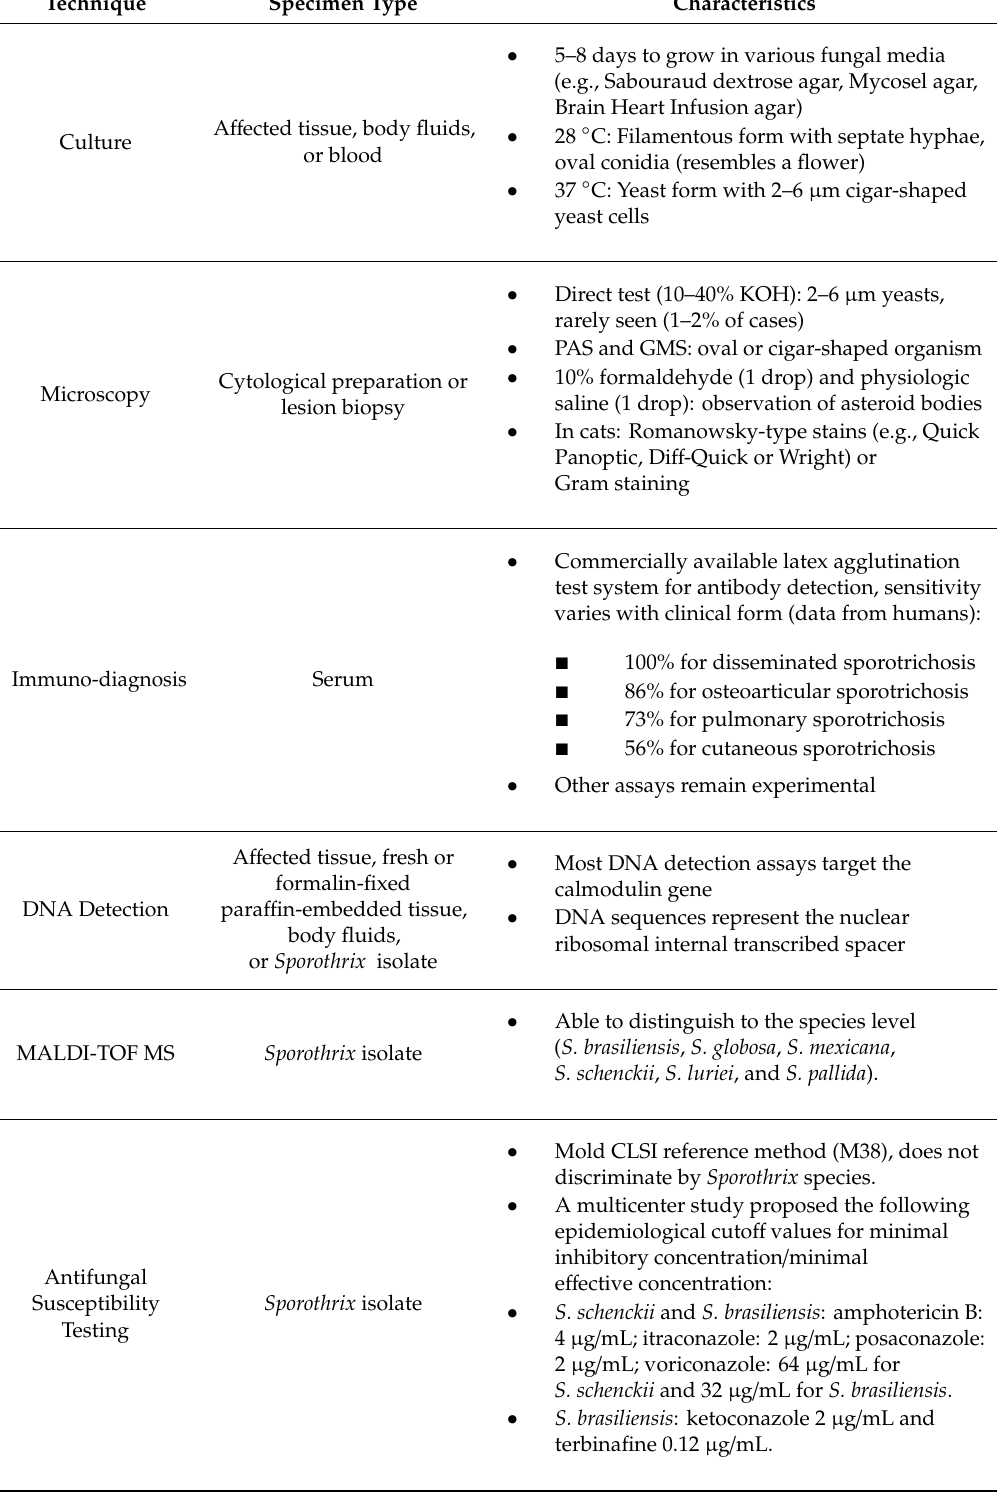
Table 1. Laboratory approaches for the diagnosis and treatment of